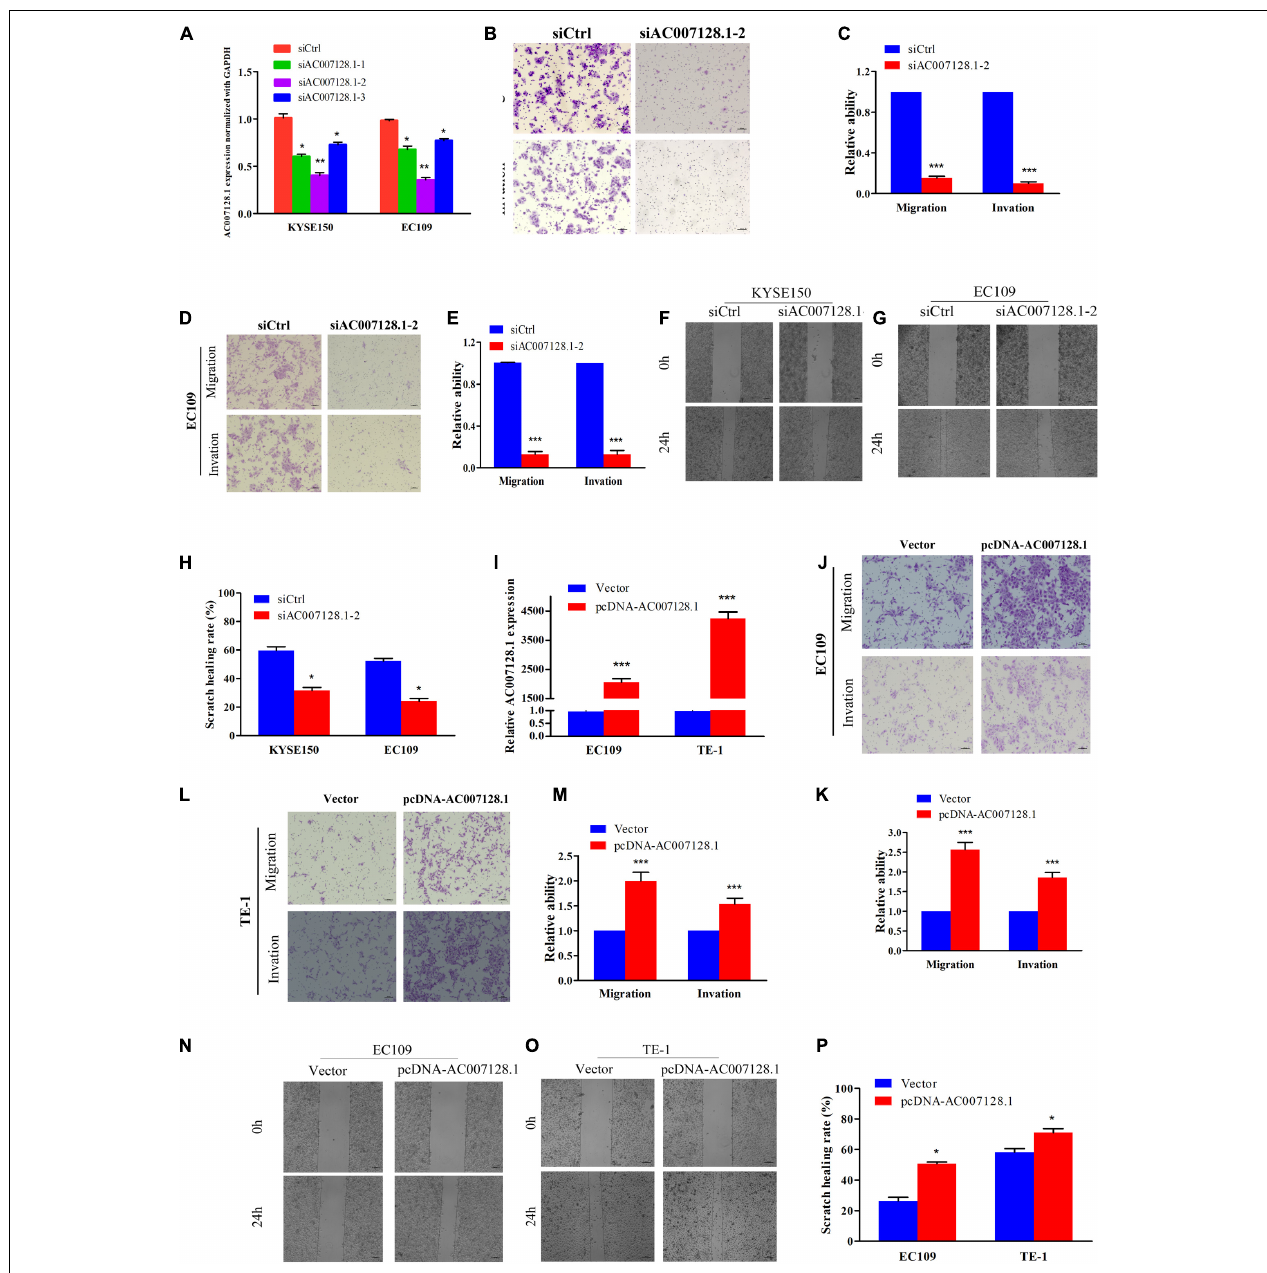
FIGURE 5 | Effects of AC007128.1 expression on ESCC cell aggressiveness. (A,I) qPCR analysis of AC007128.1 expression in si-AC007128.1-1, si-AC007128.1-2, si-AC007128.1-3, and pcDNA-AC007128.1-treated ESCC cells. (B–E) Representative micrographs of the transwell assay showing the migration and invasiveness of AC007128.1-depleted cells. (F–H) Representative micrographs of the wound healing assay showing the motilities of AC007128.1-depleted cells. (J–M) Representative micrographs of the transwell assay showing the migration and invasiveness of AC007128.1-overexpressing cells. (N–P) Representative micrographs of the wound healing assay showing the motilities of AC007128.1-overexpressing cells. Data represent mean ± SEM from three independent experiments. * P < 0.05, ** P < 0.01, and *** P < 0.001 by Student’s t -test as compared with the corresponding control.